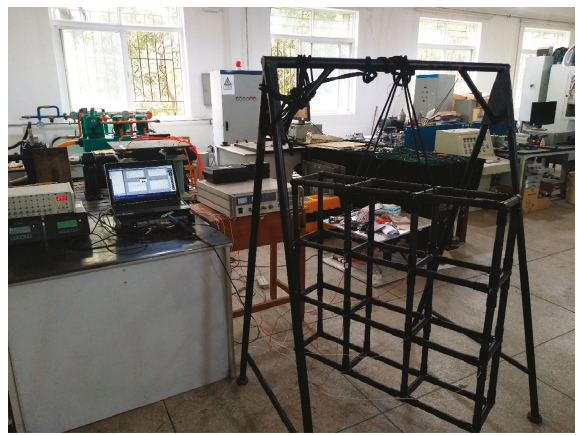
Figure 6: Modal experiment of CFRP